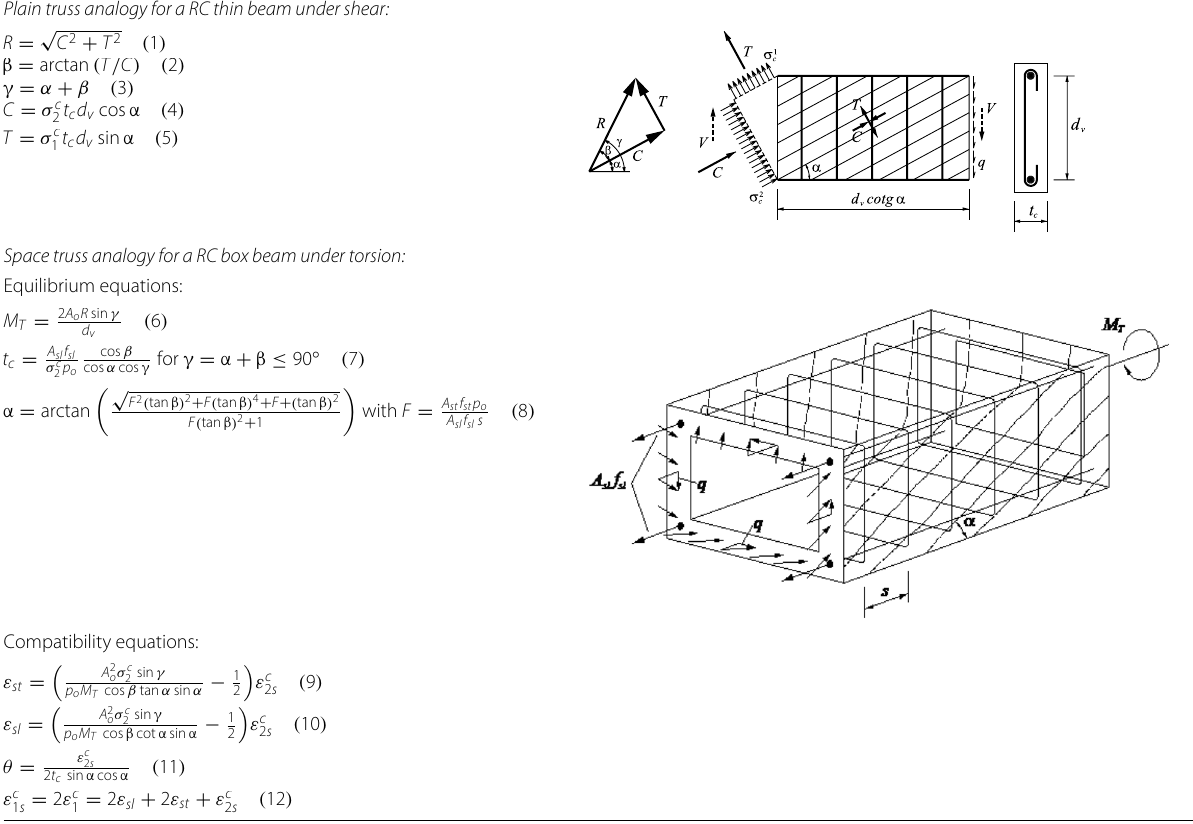
Table 1 Equilibrium and compatibility equations from GSVATM for RC beams (Bernardo et al. 2015a). Plain truss analogy for a RC thin beam under shear: √ R = C 2 + T 2 ( 1